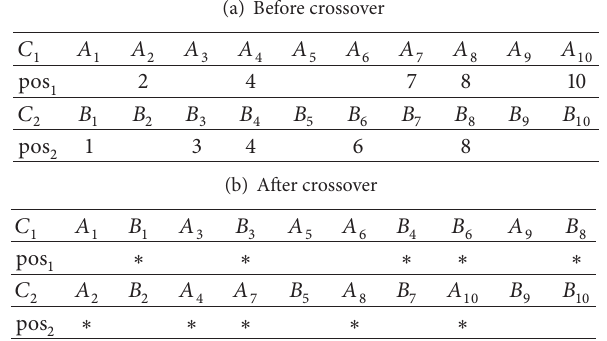
Table 3: An example of crossover of variable length and